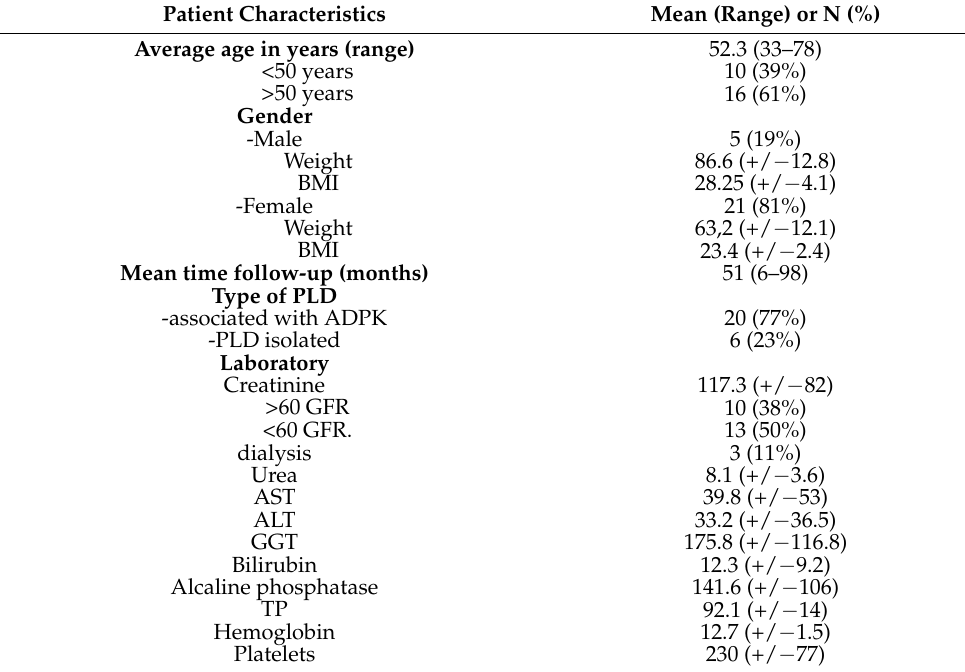
Table 1. Patient